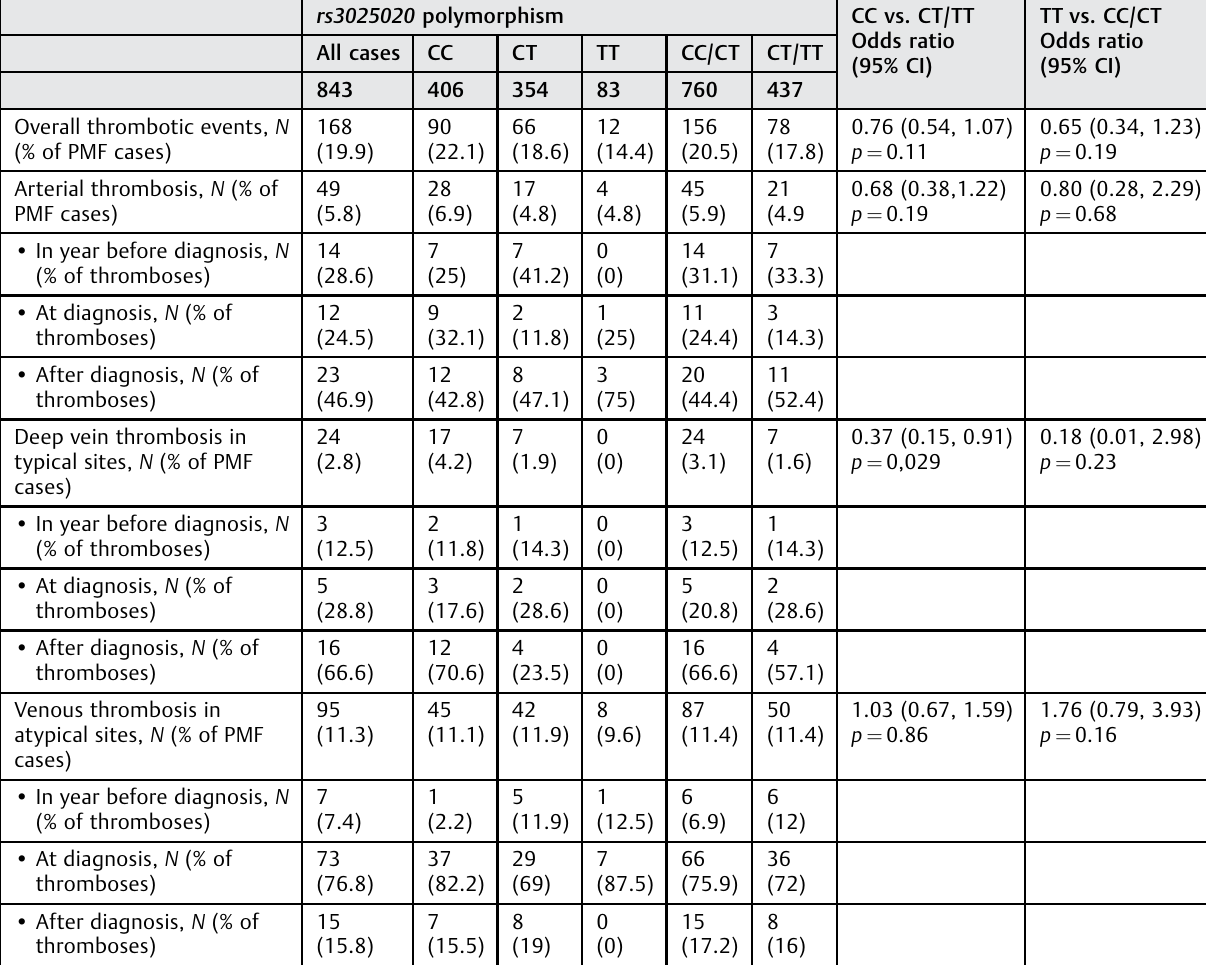
Table 3 Major thrombotic events strati fi ed for rs3025020 VEGFA